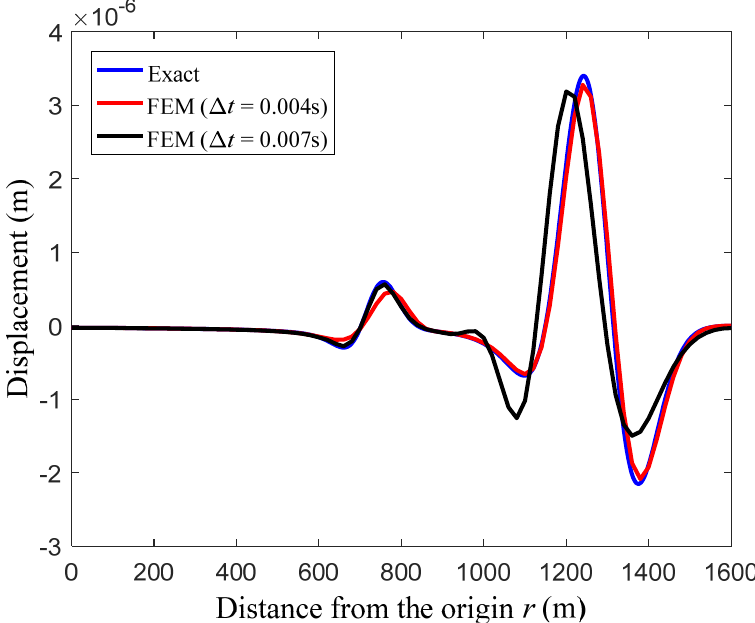
Figure 4. The calculated displacement solutions from the standard FEM along the y -axis at observation time t = 0.5 s. tion time t = 0.5